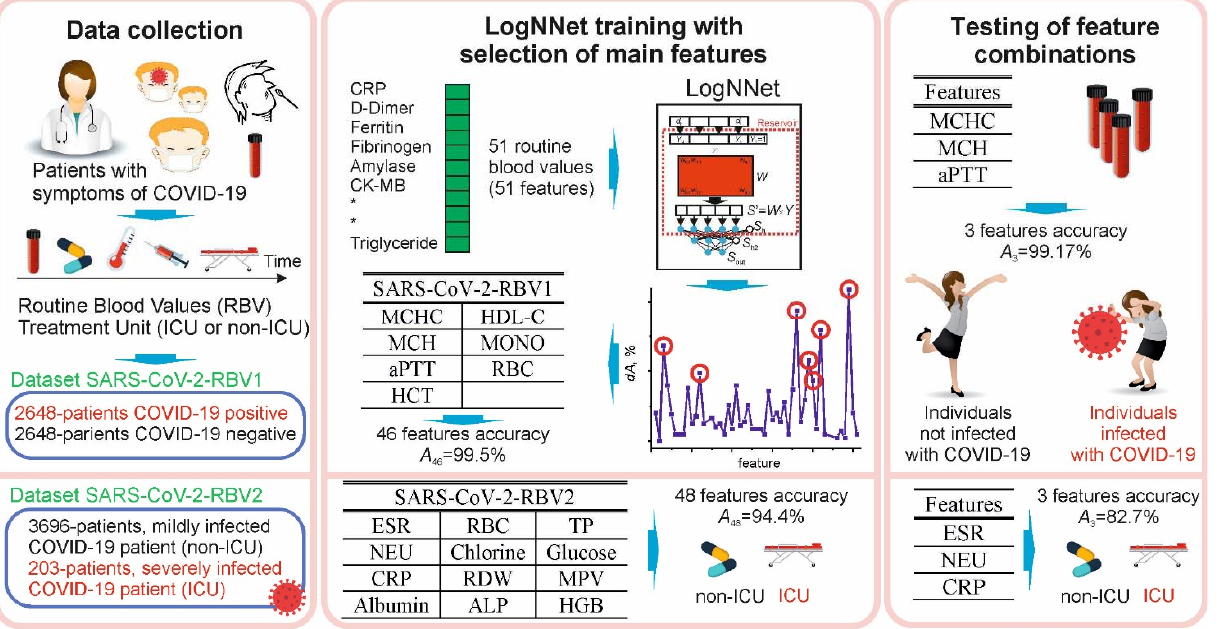
Figure 1. The main stages of the study for the diagnosis and prognosis of COVID-19 using the routine blood values: data collection, LogNNet training with the selection of main features, testing combinations of the most important features that influence the diagnosis and prognosis of the disease.